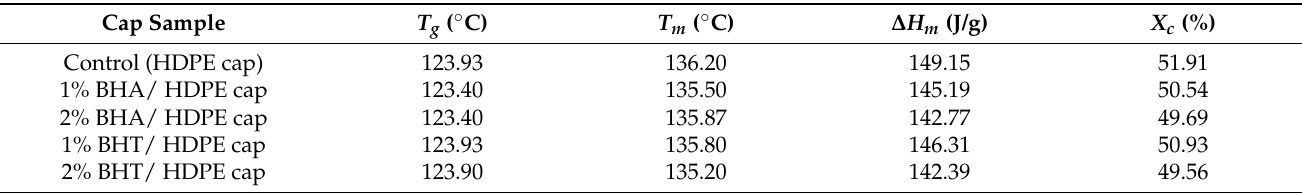
Figure 3. Thermal behavior of antioxidant active plastic bottle caps. Table 4. Thermal parameters of antioxidant active plastic bottle caps based on DSC thermograms.